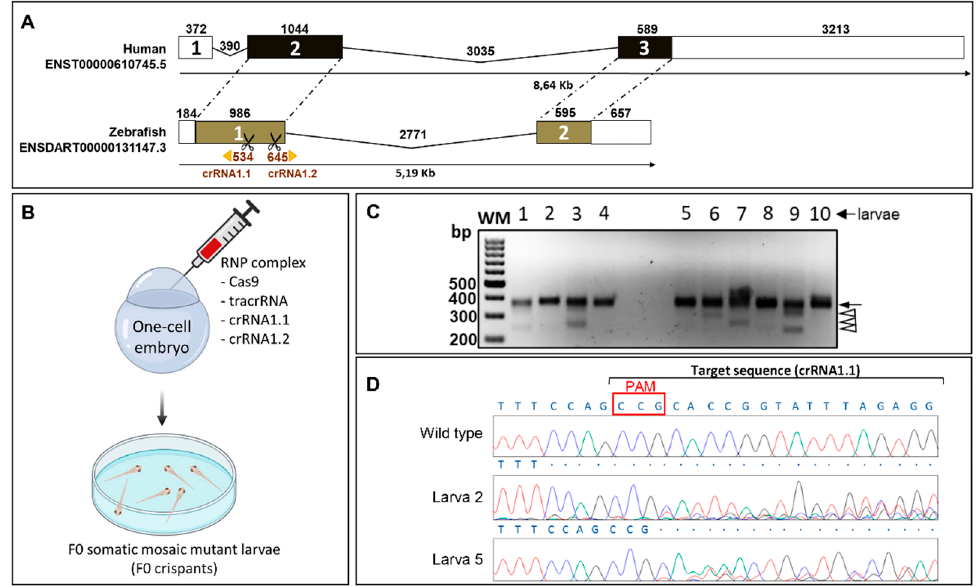
Figure 1. CYP1B1 gene structure and generation of the zebrafish cyp1b1 FO by CRISPR/Cas9 genome editing. ( A ) Comparison of exon and intron organization of human and zebrafish CYP1B1 genes. The numbers above boxes and black lines represent the length in bp of exons and introns, respectively. Untranslated regions are represented by white boxes and coding regions are represented by black and brown boxes. Dotted lines represent conserved exons. The Ensembl region comparison tool was used to obtain the scheme. Scissors indicate the position of the two CRISPR guides used to generate cyp1b1 -KO (crRNA1.1 and crRNA1.2). ( B ) Obtention of F0 somatic mosaic mutant larvae by the RNP complex (Cas9 protein/tracrRNA/crRNA 1.1/crRNA 1.2) microinjection of one-cell embryos (F0 somatic mosaic crispants, n = 215). The two crRNAs were injected simultaneously to generate cyp1b1 deletions. The scheme was created with the Biorender tool ( https://biorender.com/) (accessed on 21 April 2021). ( C ) Analysis of the CRISPR/Cas9 efficiency by agarose electrophoresis of cyp1b1 exon 1 PCR products amplified from 10 F0 larvae (48 hpf). Black arrow: main PCR product. Arrowheads: different exon 1 deletions. ( D ) Sanger sequencing of the main band (arrow) detected in ( C ). The electropherograms of two larvae (2 and 5) are shown as representative results of this analysis. Overlapping peaks indicate the presence of different mutations. Red box: protospacer adjacent motif (PAM)